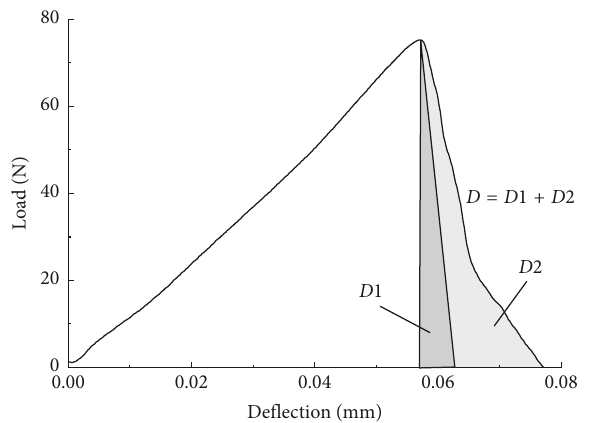
Figure 2: Typical load versus deflection curve used to calculate energy absorption capacity.